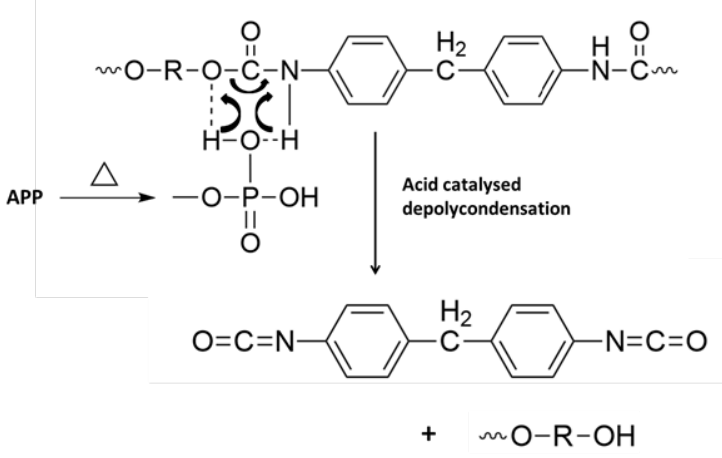
Figure 17. Mechanism of PUE depolymerization in the presence of APP, adapted from Duquesne et al. [65]. Despite the loss of thermal stability due to the presence of APP, the evolution of HRR as a function of time measured by cone calorimetry decreases more strongly for PUE than for PLA. For the former, the pHRR reduction is 82% whereas only 43% is noted for the latter. The formation of the charred structure appears very quickly after the ignition for PUE1, even if the HRR curve is not completely flattened, showing a limited stability of the charred structure formed. Conversely for PLA, during the first hundred seconds, the behavior of PLA1 is similar to pure PLA, which indicates a limited ability to char quickly. Nevertheless, the appearance of a plateau highlights the formation of a protective structure, corresponding to a thick charring behavior ([69]). The higher effectiveness of APP in PUE